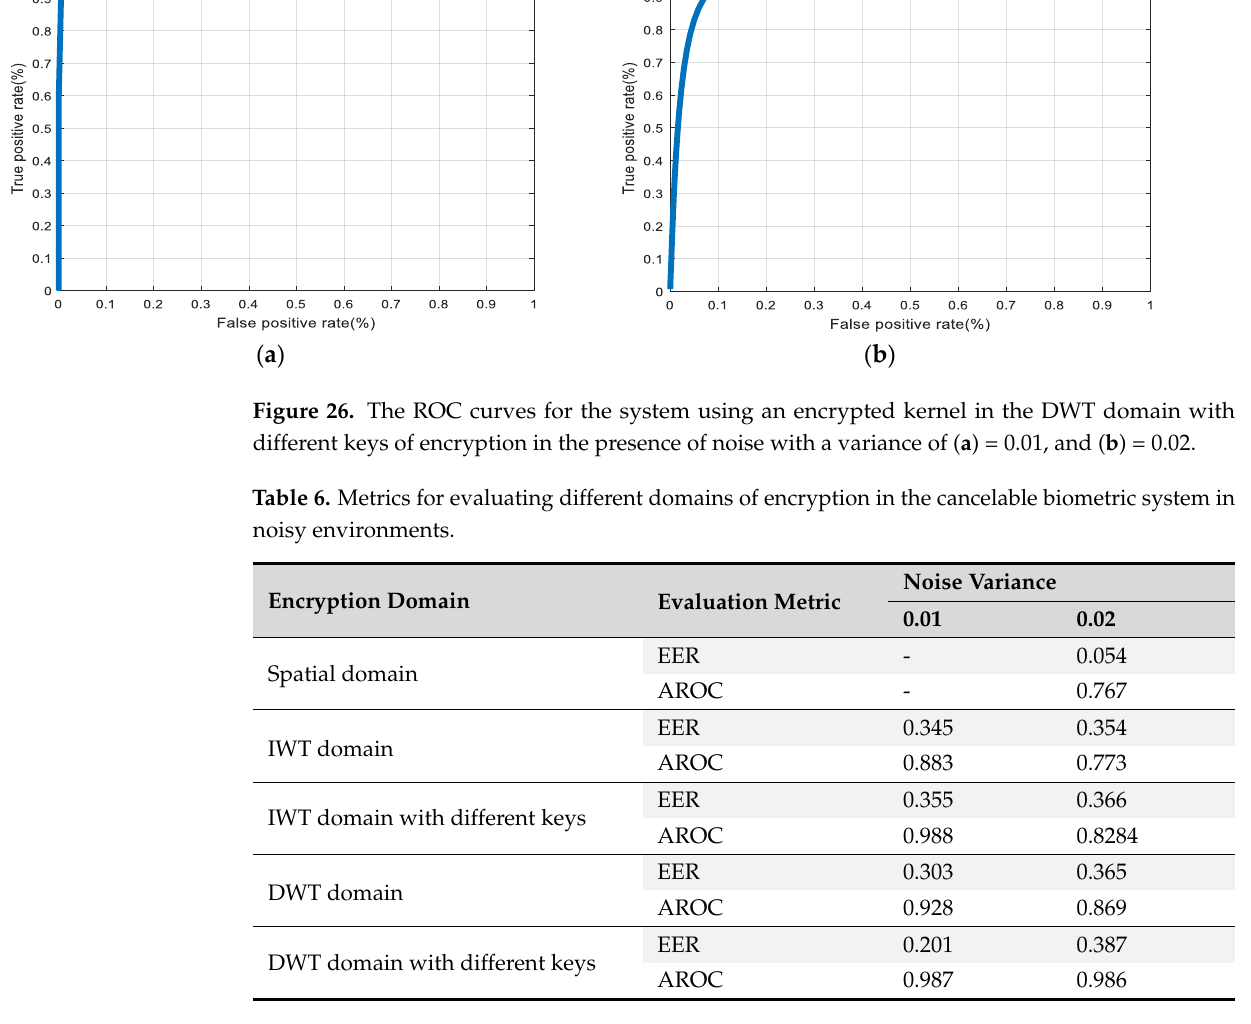
Figure 25. ROC curves for the system using an encrypted kernel in the DWT domain with similar keys of encryption in the presence of noise with a variance of ( a ) = 0.01, and ( b ) = 0.02.